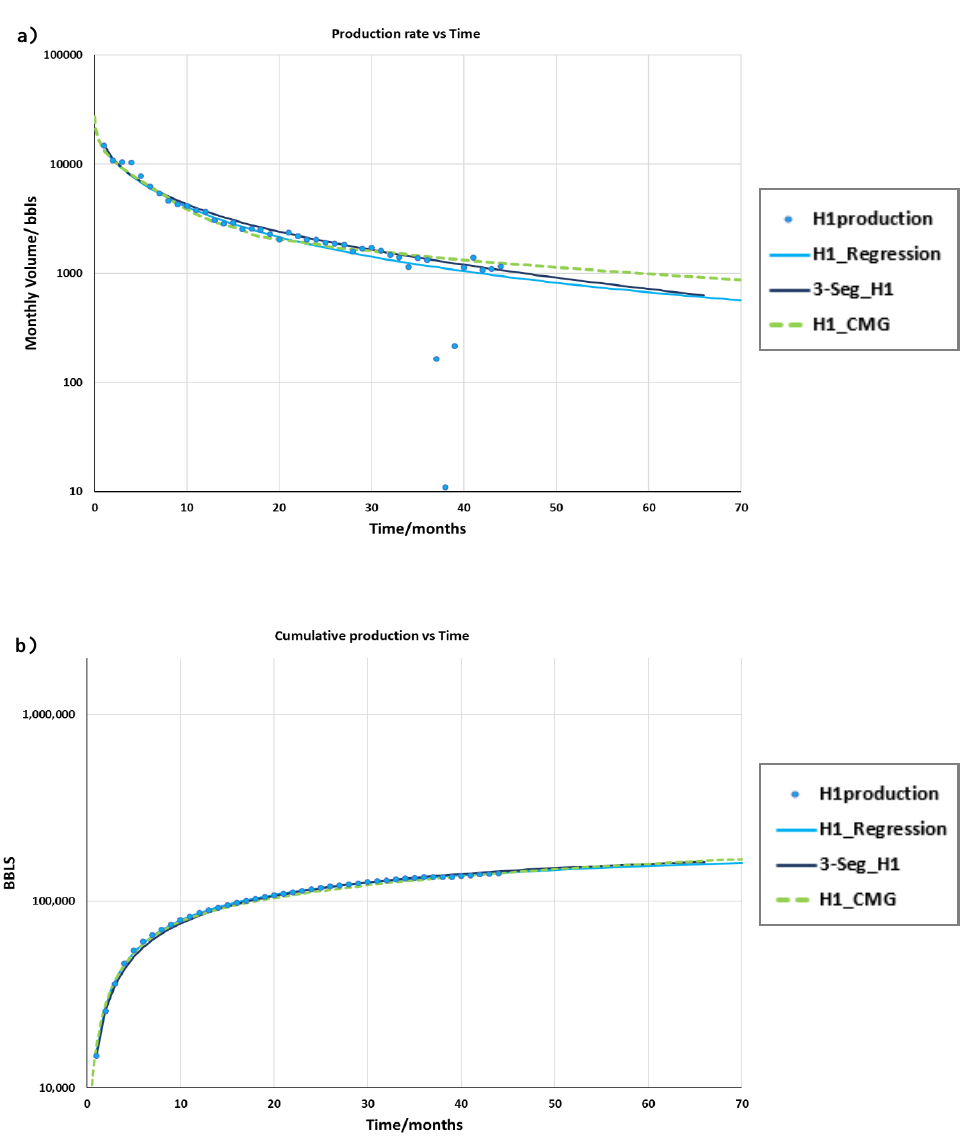
Figure 5. Short-term production forecasts. ( a ) Enhanced view of monthly production rates for H1 well for 44 months data (H1production) with corresponding forecasts from a simple regression (H1_Regression), 3-segment decline curve (3-Seg_H1) and CMG reservoir simulation (H1_CMG). ( b ) Enhanced view of cumulative production for H1 well for 44 months data with corresponding cumulative forecasts from a simple regression, 3-segment decline curve and CMG reservoir simulation (same legends as in (a)).